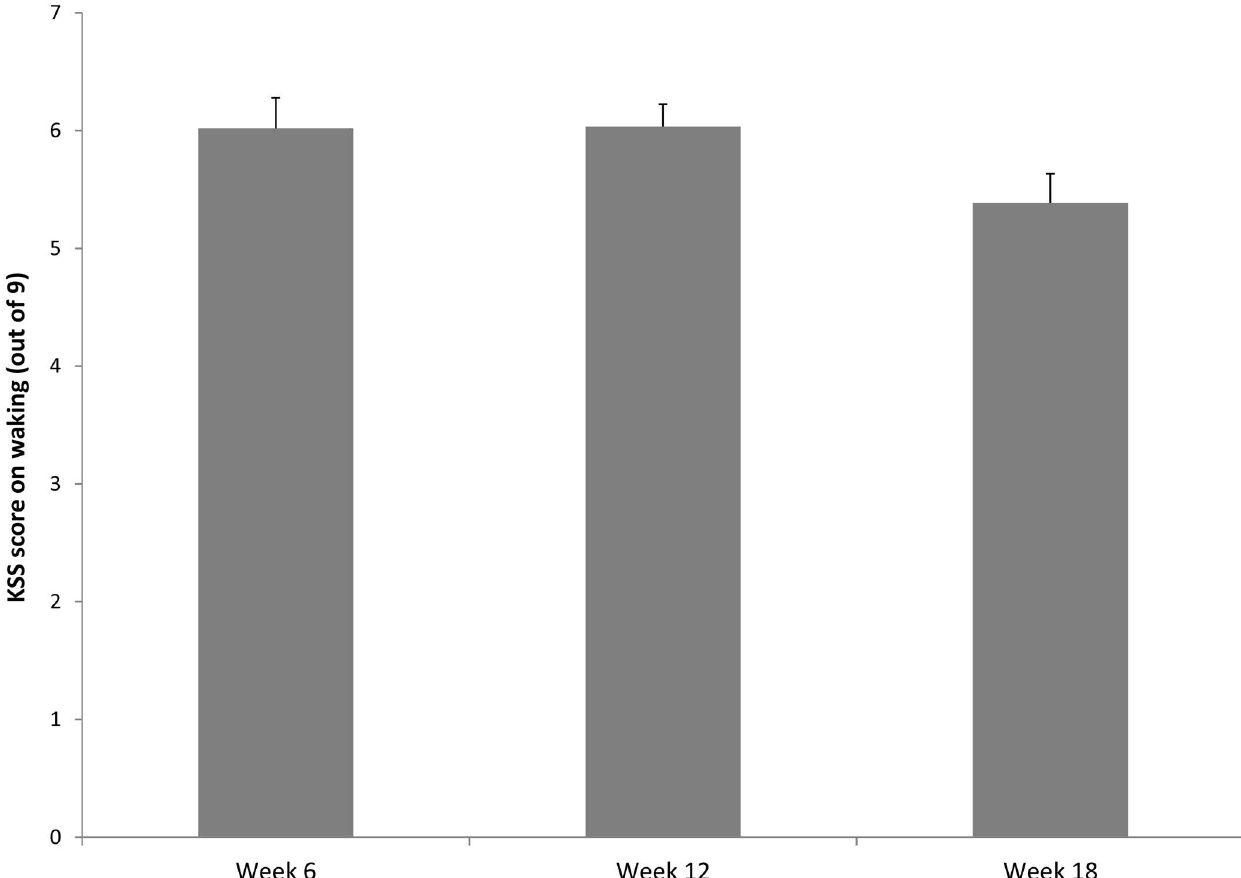
Figure 2. Postpartum daytime sleepiness, KSS score on waking, error bars represent standard error.